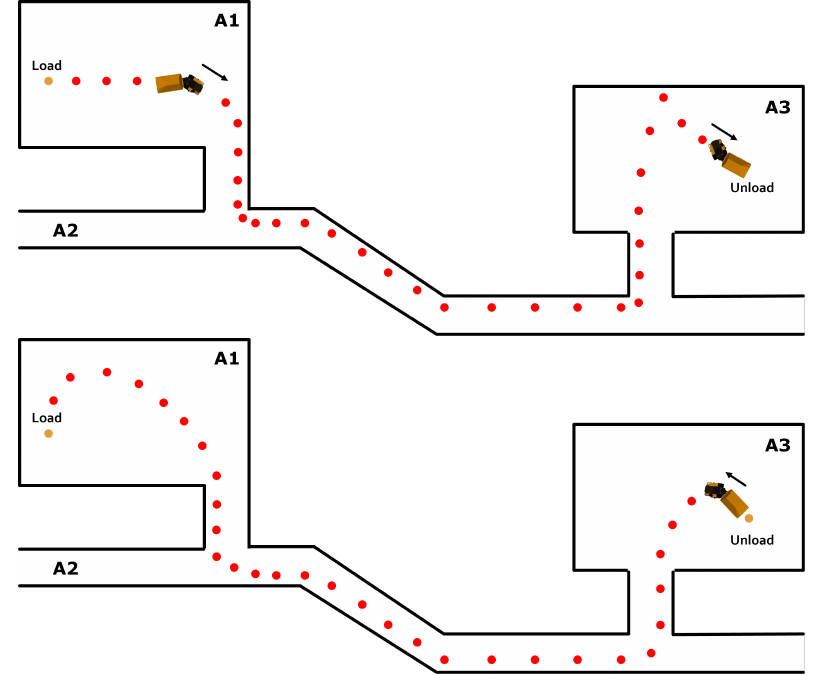
Figure 1. Road topology and operation of the load-haul-unload operation ( top ) and unload-haul- load operation ( bottom ). A1 represents the loading area, A3 represents the unloading area, and A2 represents the roadway connecting the loading/unloading areas. Waypoints are shown in red and checkpoints are shown in